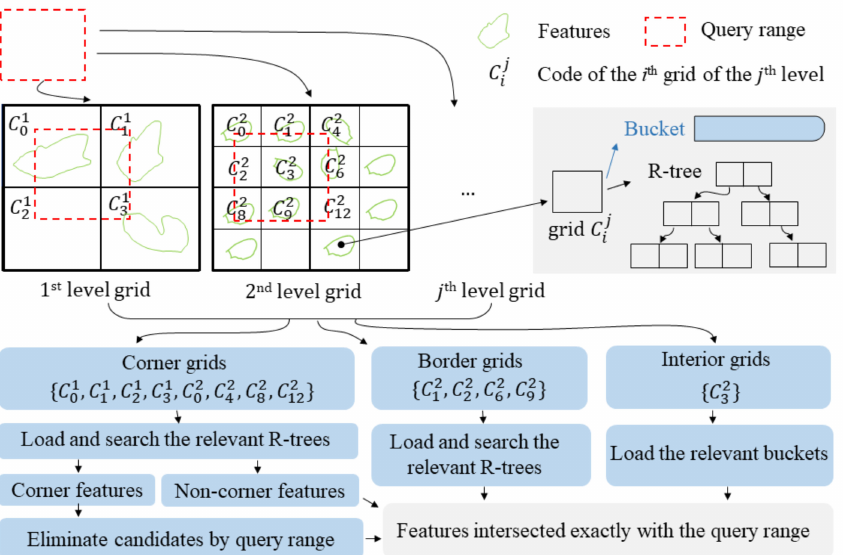
Figure 2. Features are distributed into grids of different levels according to their extents and locations, with each of the grids being attached to an R-tree and a bucket. When a range query is implemented, the corner, border, and interior grids covered by the query range are calculated. Features intersecting with the query range are filtered by loading and searching the relevant R-trees or by loading the relevant